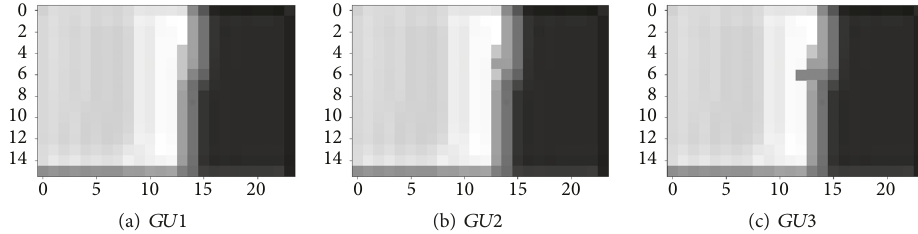
Figure 9: The 𝐺𝑈 representation in different trajectory 1 of the line tracing robot.